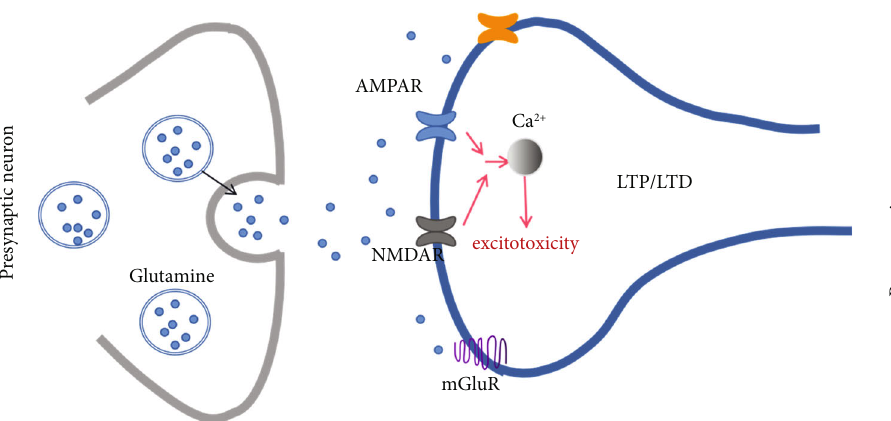
Figure 1: The transmission of glutamate. Glutamate mainly acts on glutamate receptors [AMPAR, NMDAR, kainic acid receptor (KAR), and metabolotropic glutamate receptors (mGluR)]. Commonly, glutamate receptors are involved in synaptic plasticity [long-term potentiation (LTP)/long-term depression (LTD)] and the transmission of excitatory neurotransmitters. After stroke, ischemia and hypoxia of the brain will lead to excessive activation of glutamate receptors, causing Ca 2+ in fl ux, and increased intracellular Ca 2+ concentrations cause excitotoxicity and cytotoxic e ff ects.